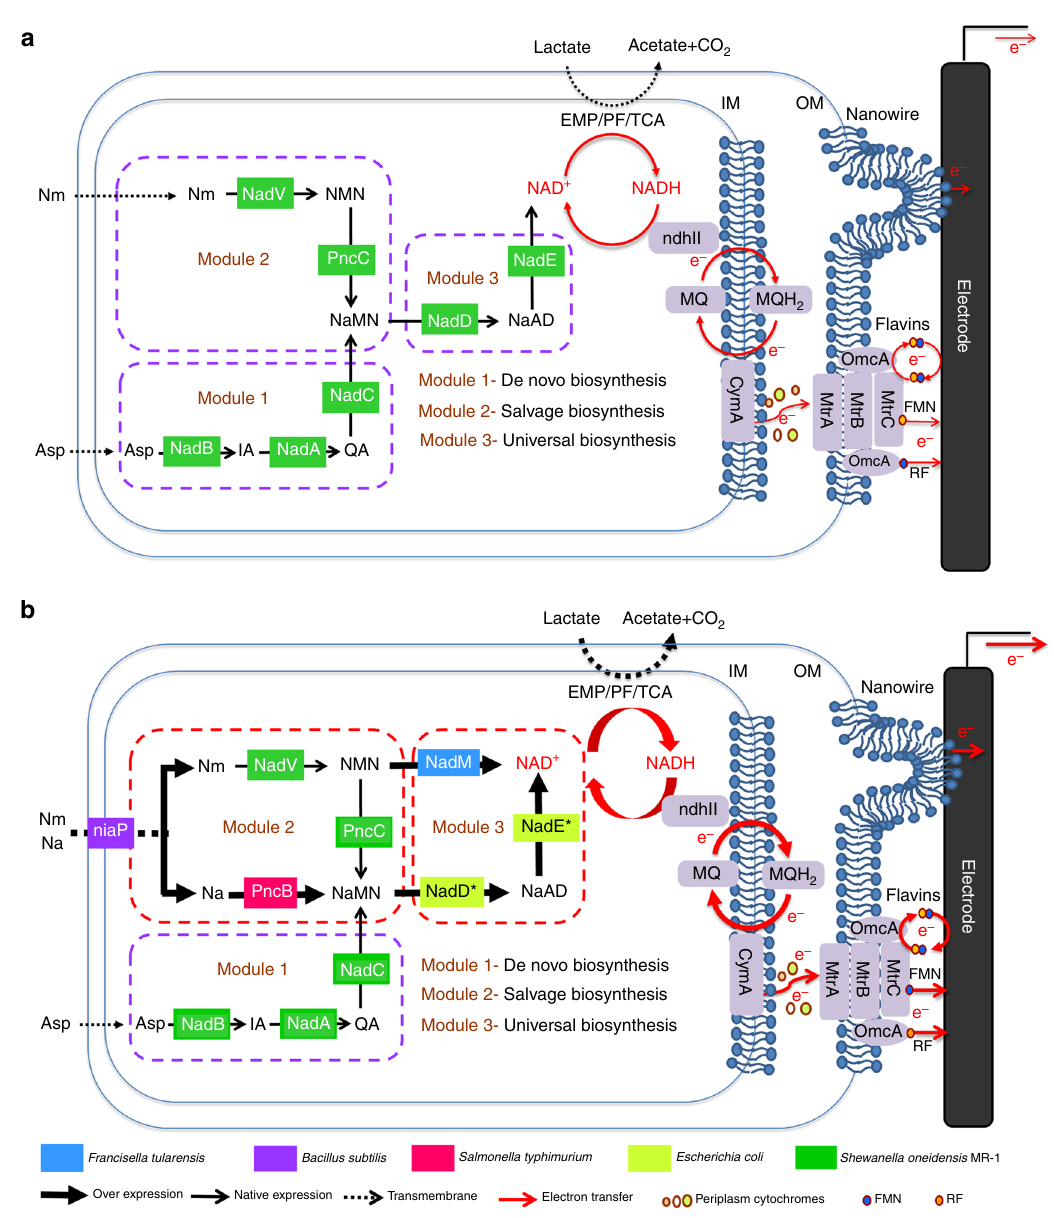
Fig. 1 Schematic of modular design to enhance NAD + biosynthesis and EET rate in S. oneidensis MR-1. a The NAD + biosynthesis pathway of the wild-type S. oneidensis